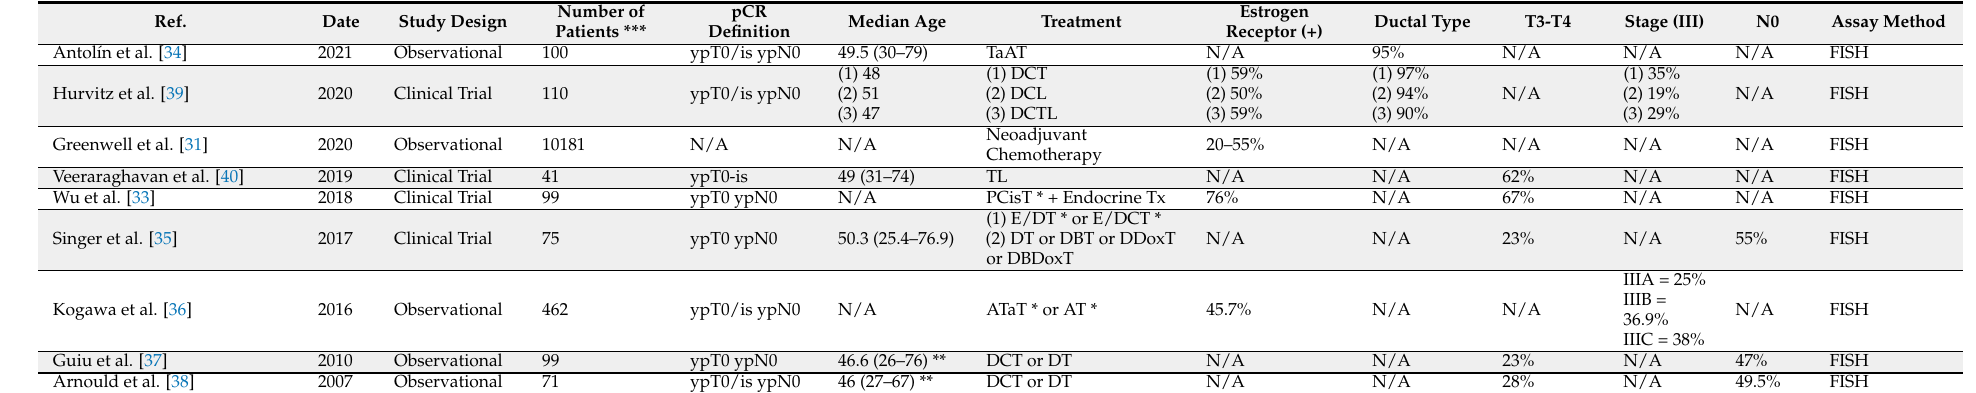
Table 1. Characteristics of the